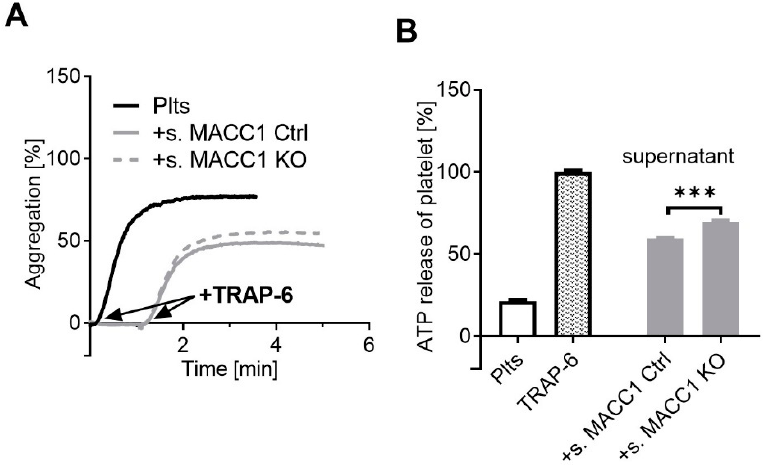
Figure 2. The cell supernatant of SW620 cells interferes with platelet activation. ( A ) Representative traces showing platelet aggregation in response to TRAP-6 (black) and its inhibition by supernatant of SW620 MACC1 Ctrl cells (solid grey line) and a lower inhibition by MACC1 KO cells (dashed grey line), respectively. ( B ) Quantification of ATP release from resting platelets, platelets activated with TRAP-6, and co-incubated with supernatant of SW620 MACC1 Ctrl (s. MACC1 Ctrl) and MACC1 KO (s. MACC1 KO) cells, respectively. Data indicate a soluble inhibitory compound in the cell supernatant that is more potent in the SW620 Ctrl cells. *** p < 0.001 .